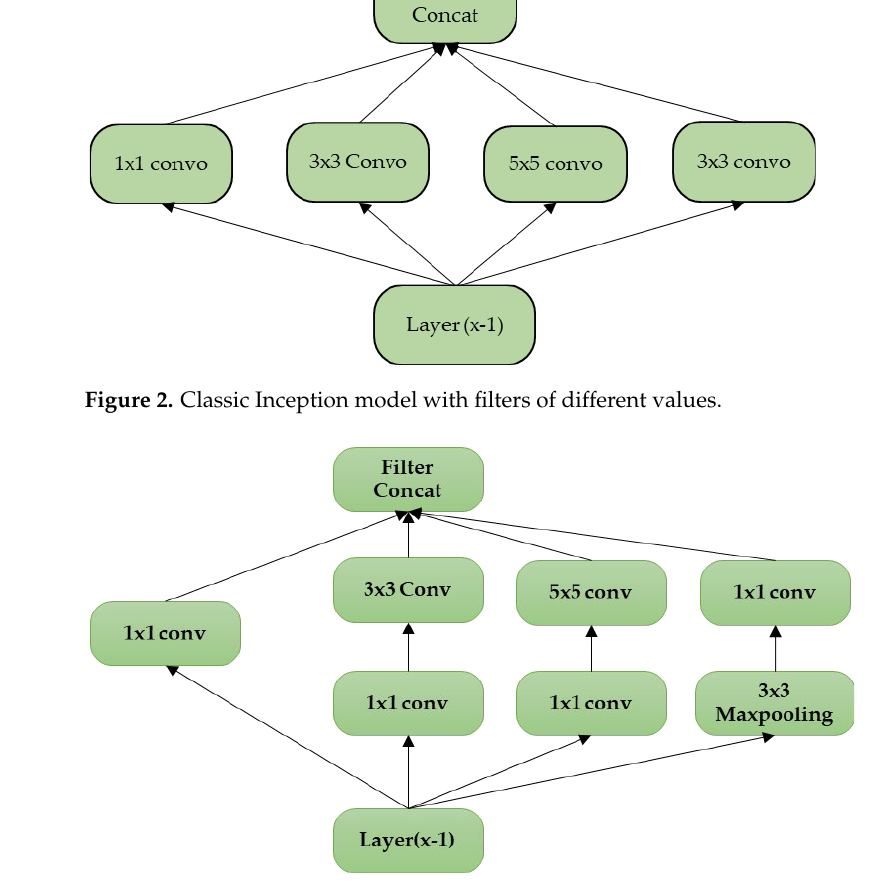
Table 1. Different convolution filter-based feature extractors and classification